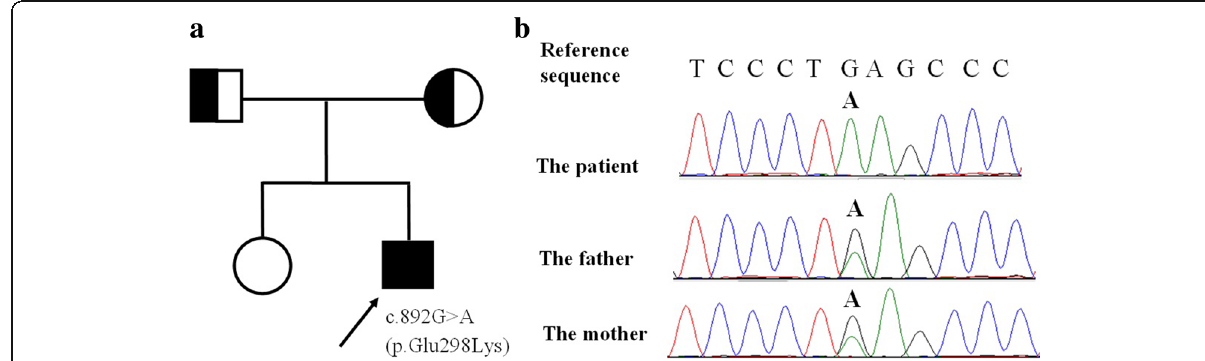
Fig. 1 The family pedigree showing the mutations detected in CLN6 . a The pedigree of the family with late infantile neuronal ceroid lipofuscinosis (LINCL). The arrow indicates the proband; his parents have no signs of LINCL. b The mutations detected in the family. The proband is homozygous, while the parents are